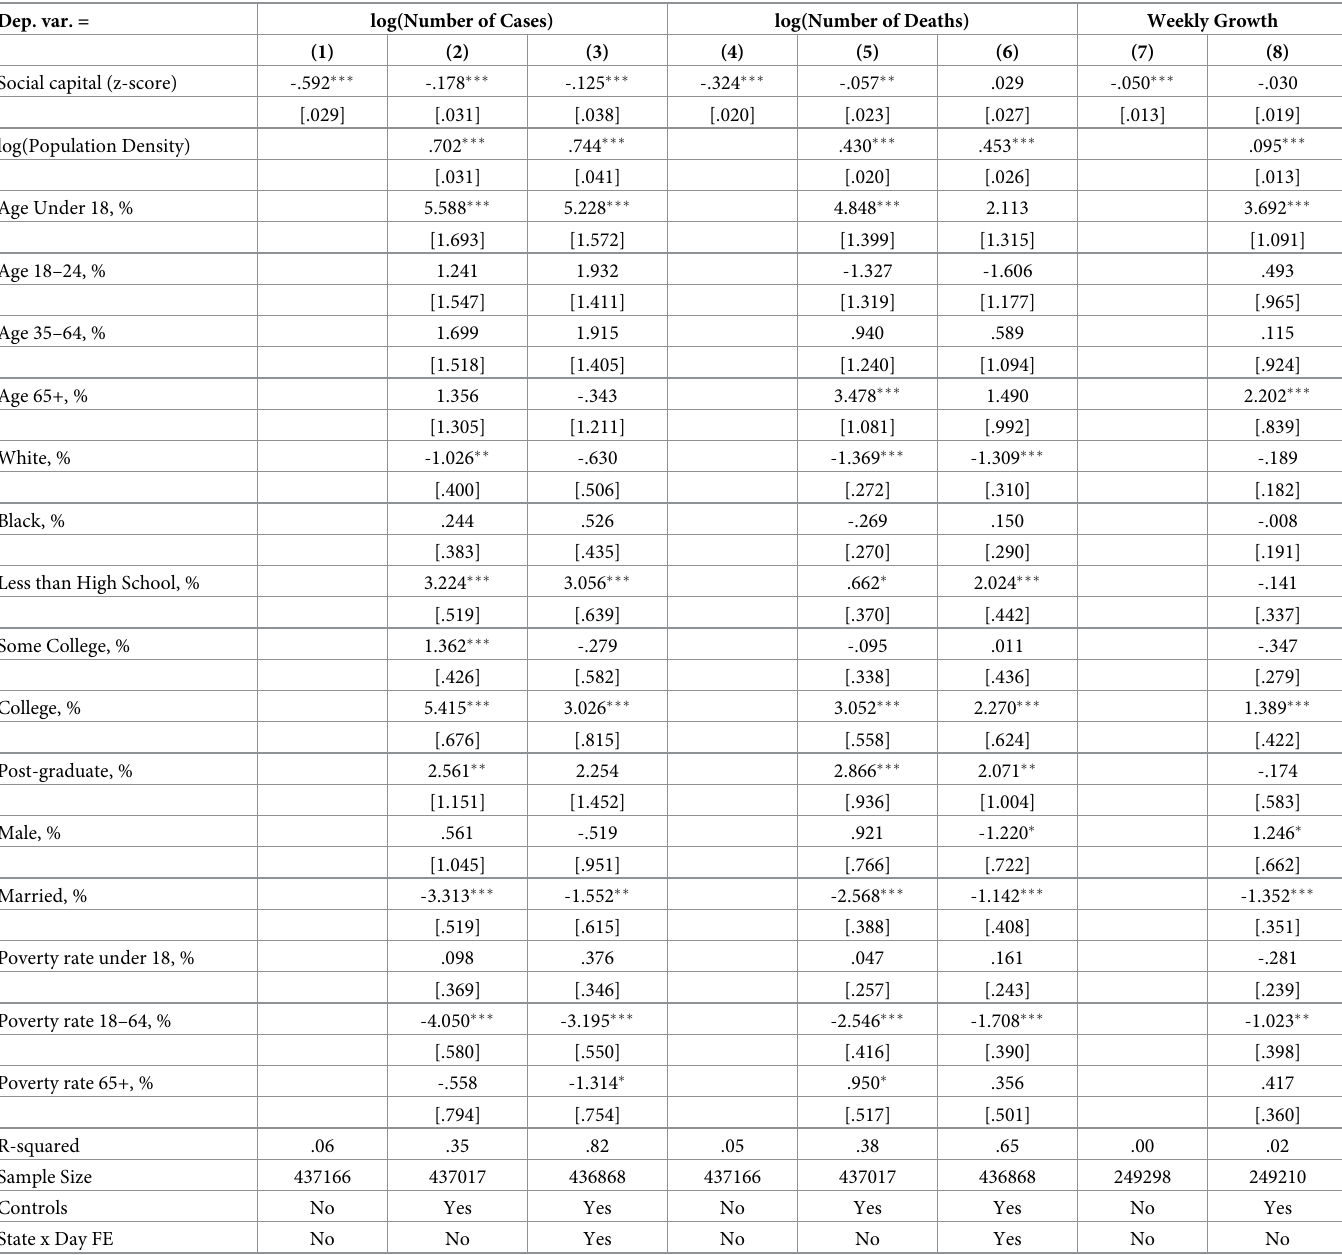
Table 1. The effects of social capital on infections and the spread of COVID-19. Dep. var.